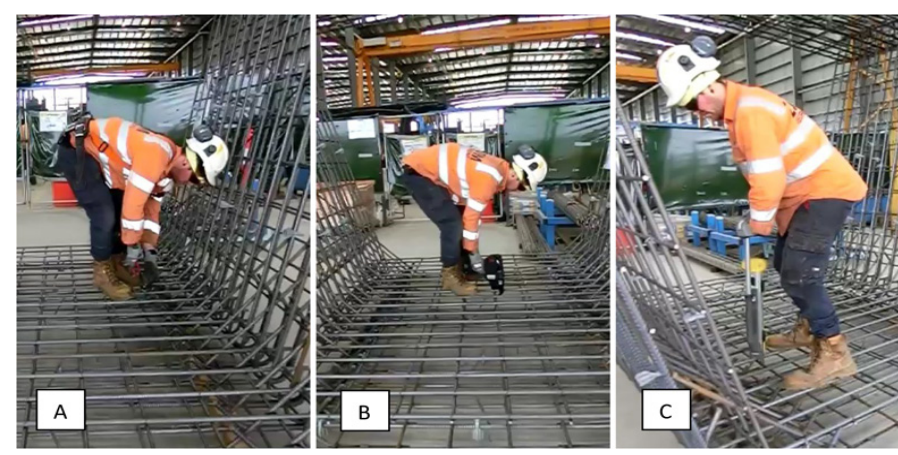
Figure 3 Use of the conventional pincer-cutter (A), power tying tool (B) and long handled stapler tool (C) at ground level The three tools produced significantly different values for mean trunk inclination at all